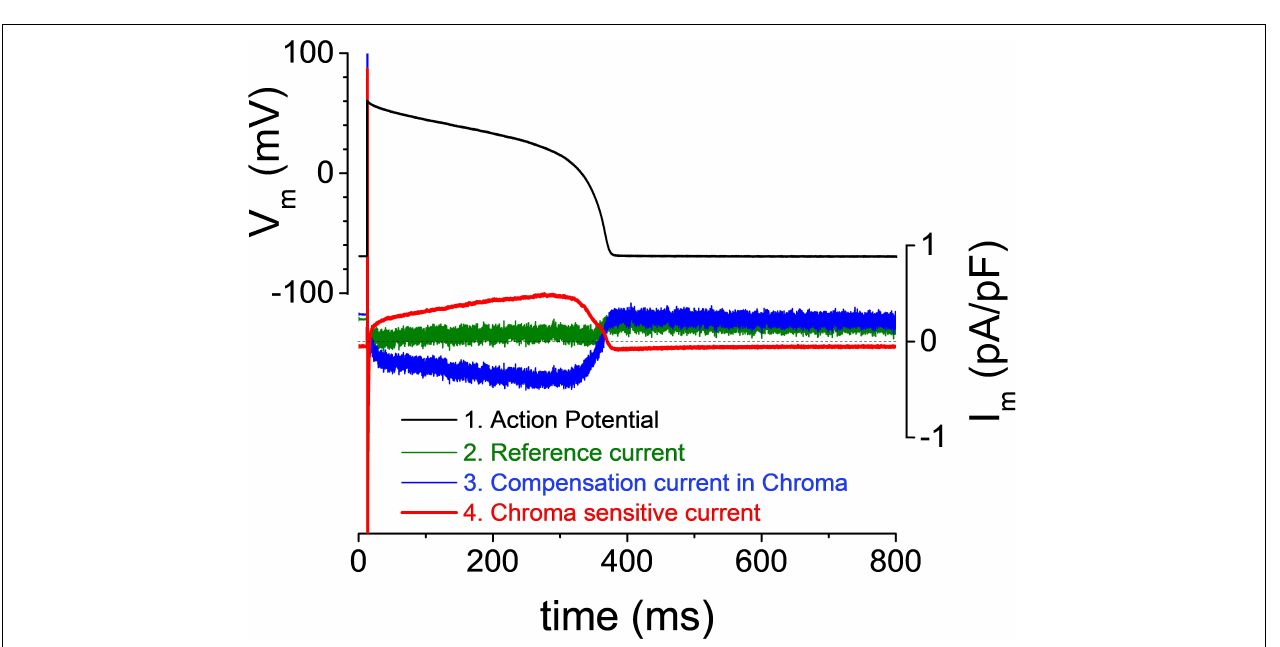
FIGURE 1 | Recording the membrane current with the single electrode (discontinuous) voltage clamp technique. Ch.A, Ch.B, ... Ch.X indicate different channel types in the membrane. The amplifier measures the total current passing through the membrane. If the membrane contains different channels, the current measured by the amplifier will be the sum of the individual currents. If the goal is to determine the current generated by a single channel type, all other channels must be turned off.